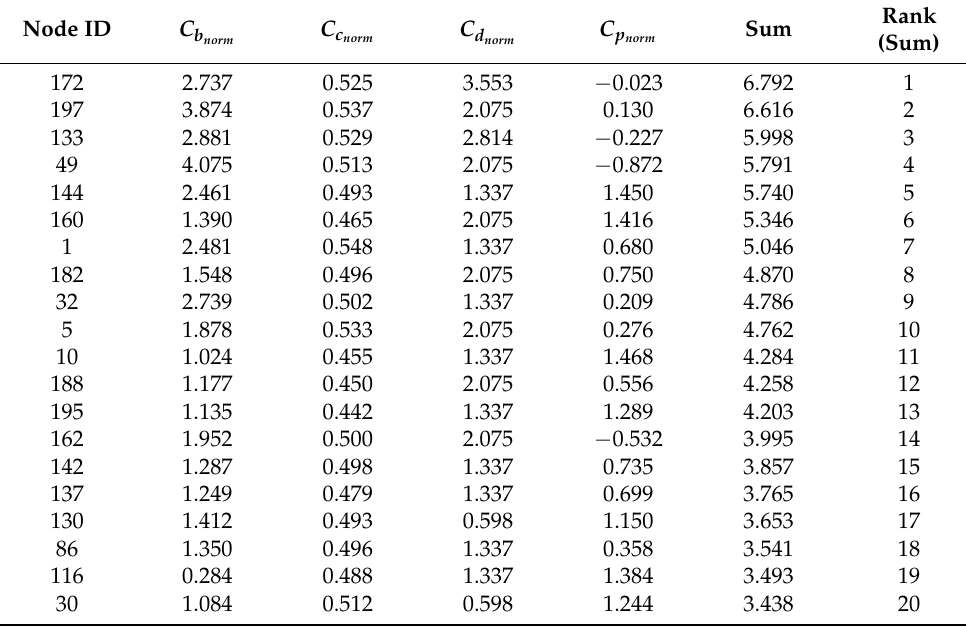
Table 1. Top 20 most critical nodes utilizing the Combined Metric approach. Node